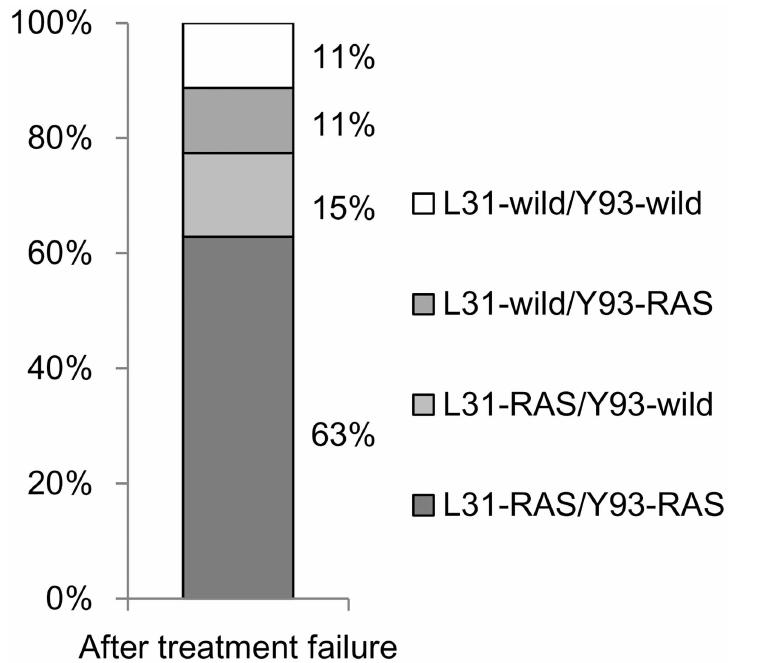
Fig 2. Prevalenceof signature RASs in NS5A after treatment failure. The prevalenceof signature RAS at L31 and Y93 in NS5A after treatment failure in total